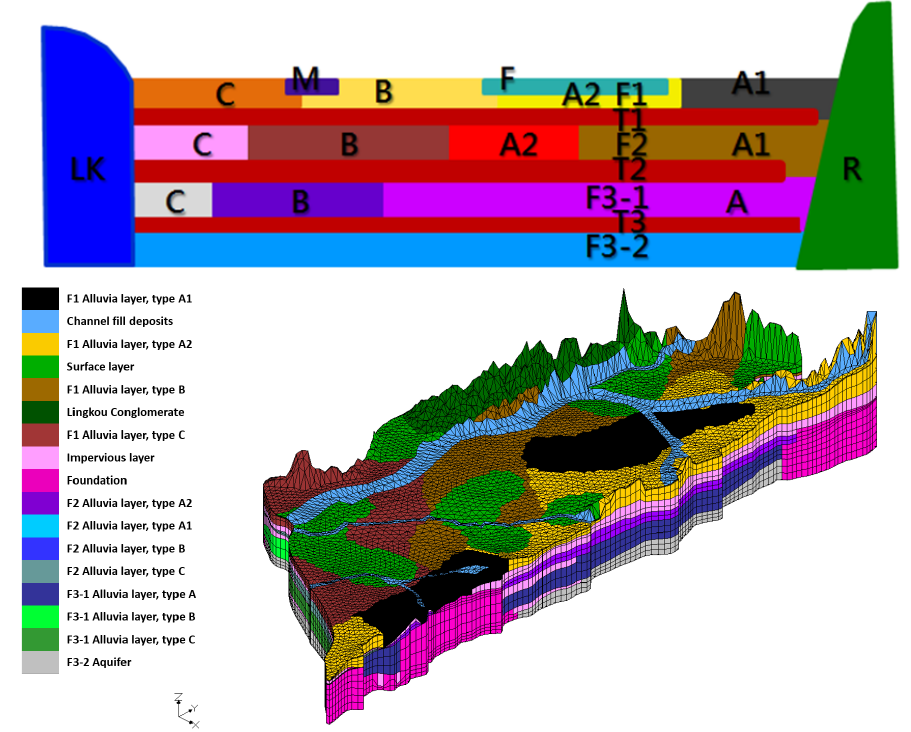
Figure 3. The ( top ) panel illustrates the hydrogeological units (please refer to Table 1 for the definition of each unit), and the ( bottom ) shows the 3D mesh over the PAP used for WASH123D